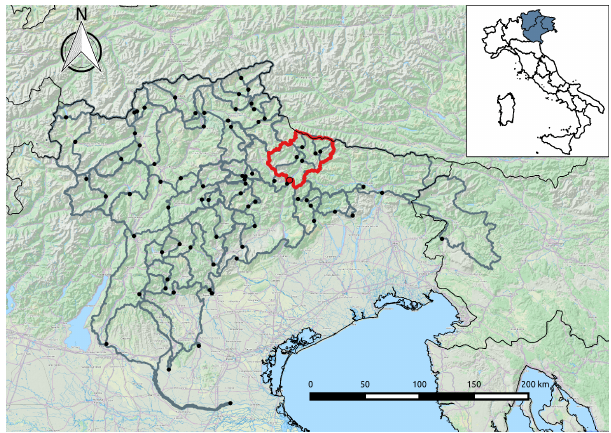
Figure 1. Location of the 76 Triveneto gauging stations (black points) considered in the present study. Grey lines represent catch- ments boundaries. Pieve di Cadore, an example target basin, is high- lighted in red.